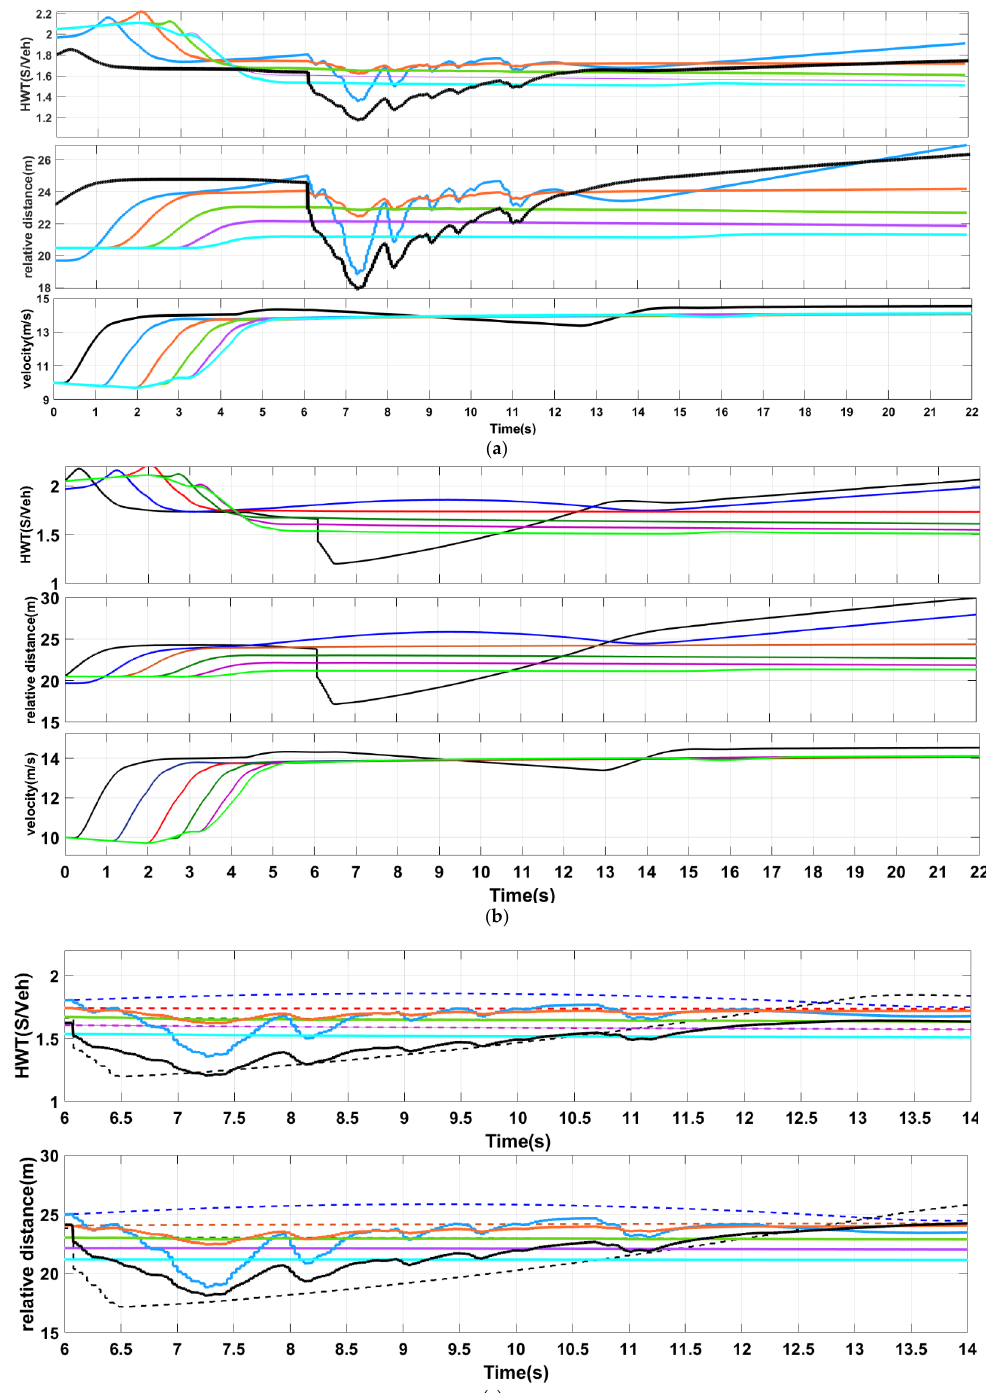
Figure 11. Simulation curve of CAVF fleet and CACCNF fleet in scenario 2: ( a ) CAVF fleet — HWT following distance speed; ( b ) CACCNF fleet — HWT following distance speed; ( c ) comparison of follow-up distance and HWT between CANF team and CACCNF team.